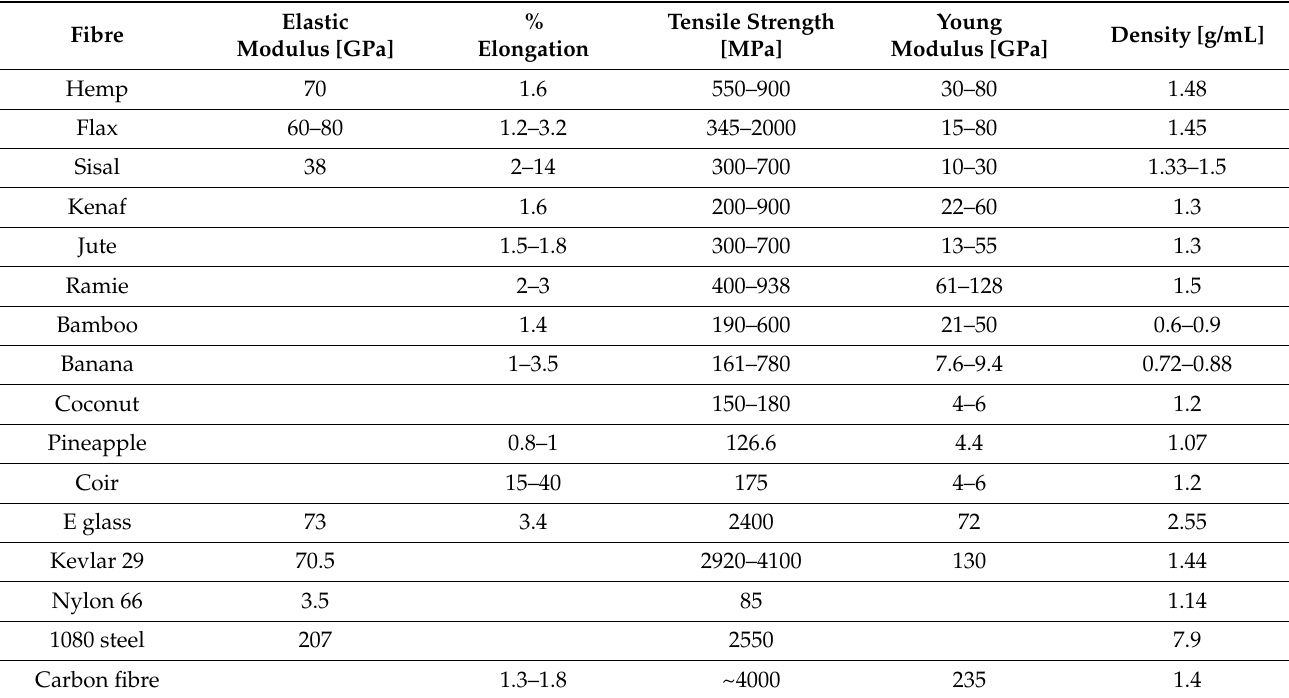
Table 2. Some of the properties of the selected natural fibres